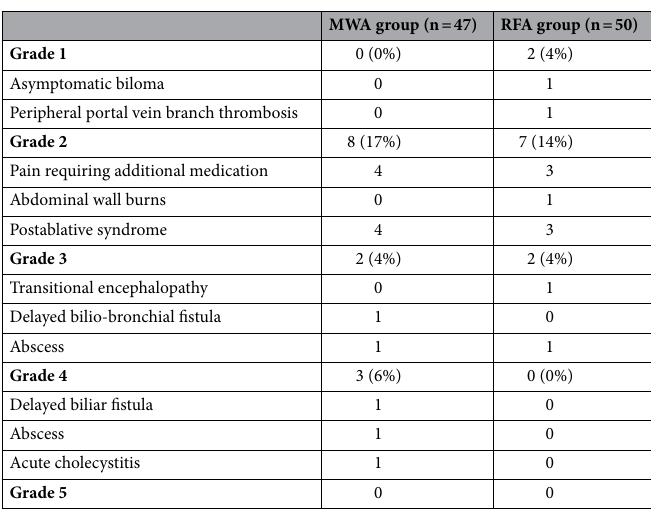
Table 3. Complications. Data are n, n (%). Analyses are by ablated tumor.